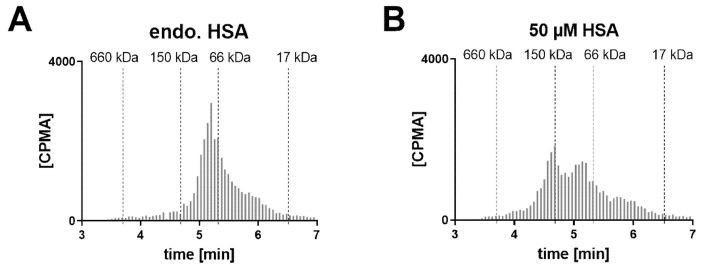
Figure 7. Radio-size exclusion chromatograms of FabA–HSA complexes formed after 4 h incubation with human VH (donor with eye disease) supplemented with albumin. The FabA concentration was 0.57 µ M and the HSA concentration was ( A ) at endogenous levels or ( B ) at 50 µ